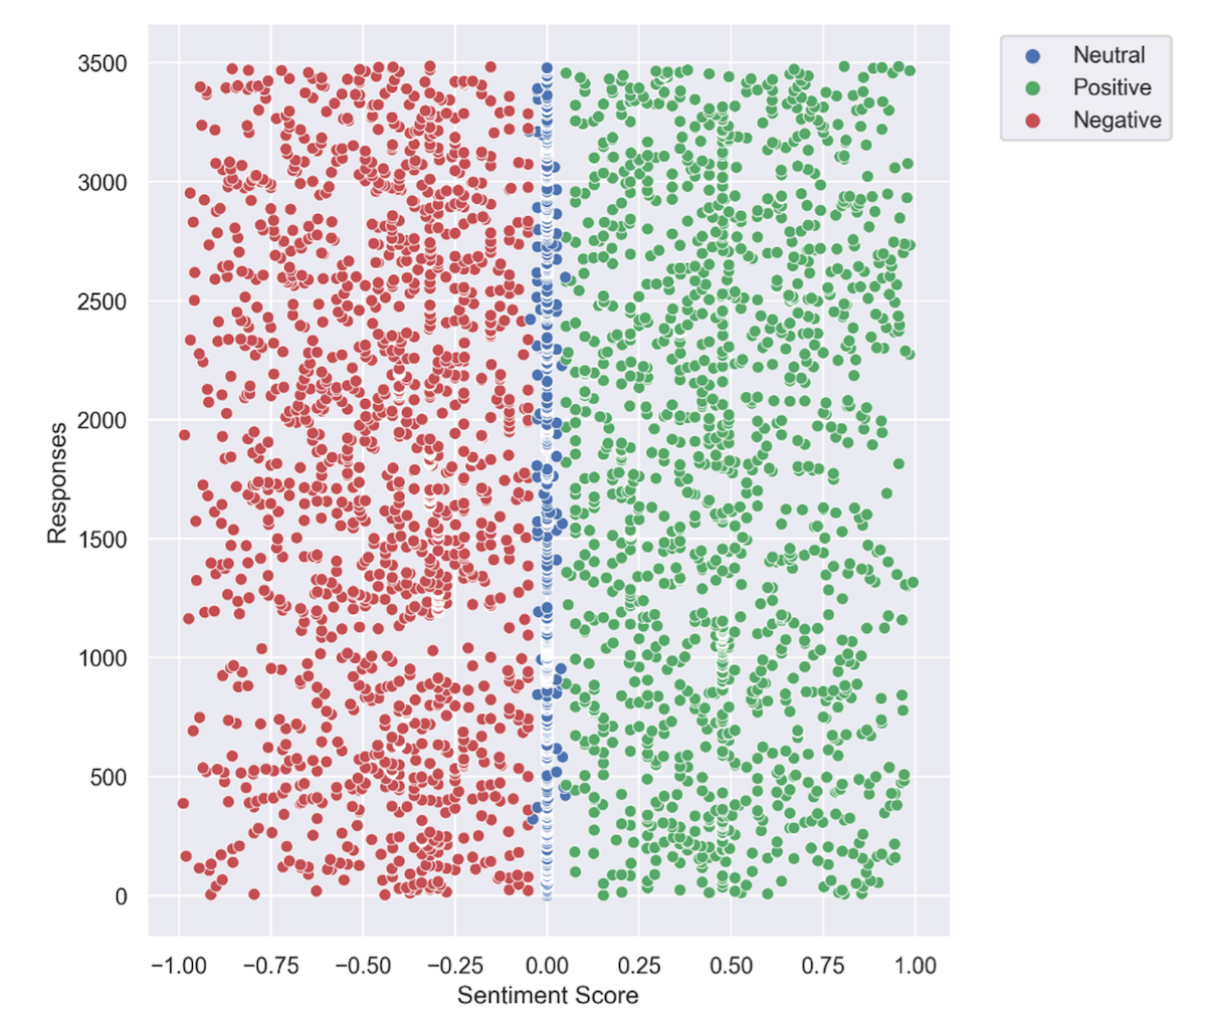
Figure 1. Distribution of standardized Valence Aware Dictionary and Sentiment Reasoner (VADER) sentiment scores in COVID-19 impact stories reported by a sample of Australian adults during May 2020.